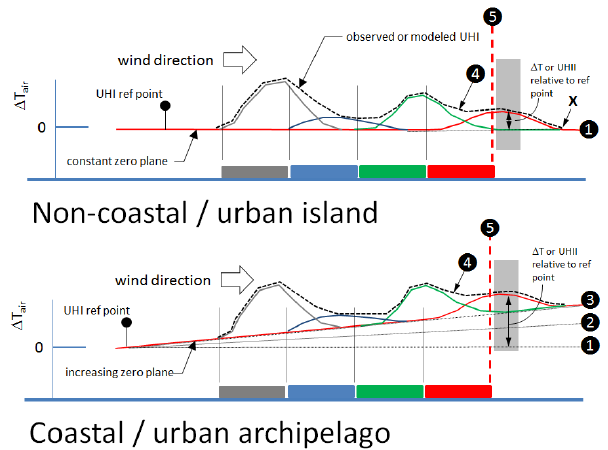
Figure 8. Single/multi core UHI versus climate archipelago. The colored blocks represent different urban land uses and land covers and the similarly-colored lines represent the temperature (localized UHI) corresponding to each block. The black dash line represents the sum of the local and downwind-displaced UHI at each point along the wind direction.